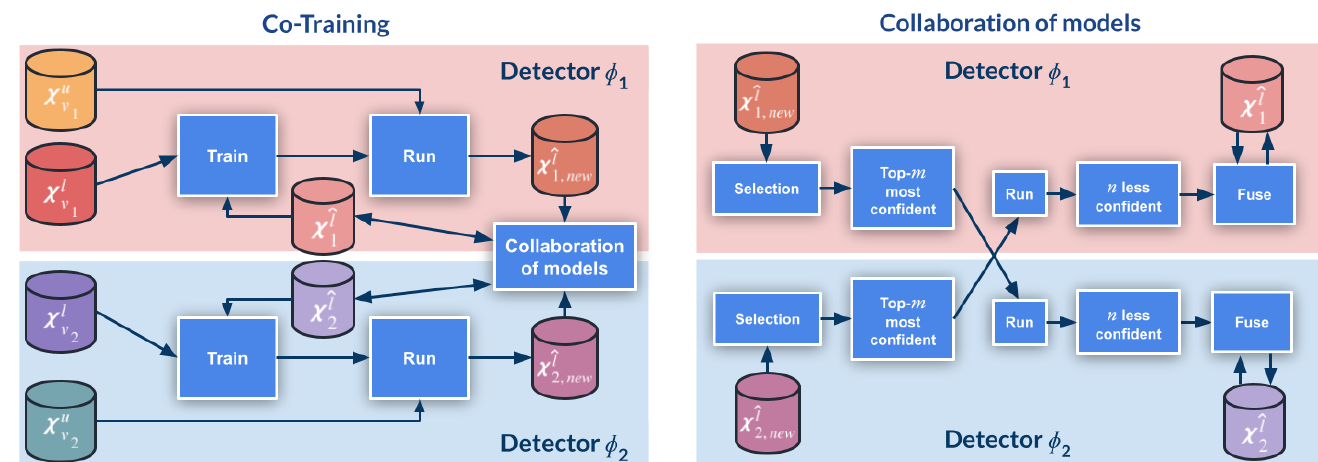
Figure 2. Co-training pipeline: the left diagram shows the global block structure, while the right diagram details the collaboration of models block. Symbols and procedures are based on Algorithms 1. We refer to this algorithm and the main text for a detailed explanation. Algorithm 1: Self-labeling of object BBs by